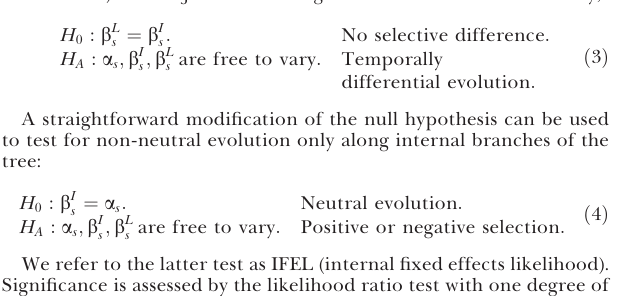
Figure S1. Joint PR and RT Phylogenies Inferred from Combined Sample Data Ethiopian and South African sequence samples appear reciprocally monophyletic, both in the maximum likelihood and in the 50% consensus Bayesian trees. Figure S2. Inferred Evolutionary History at Codon 82 in RT